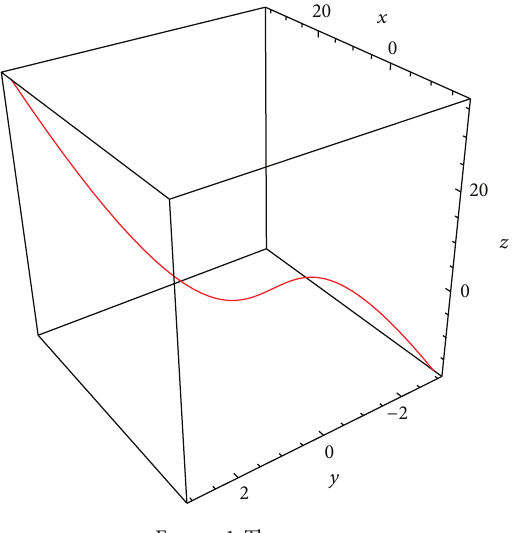
Figure 1: The curve 𝛼